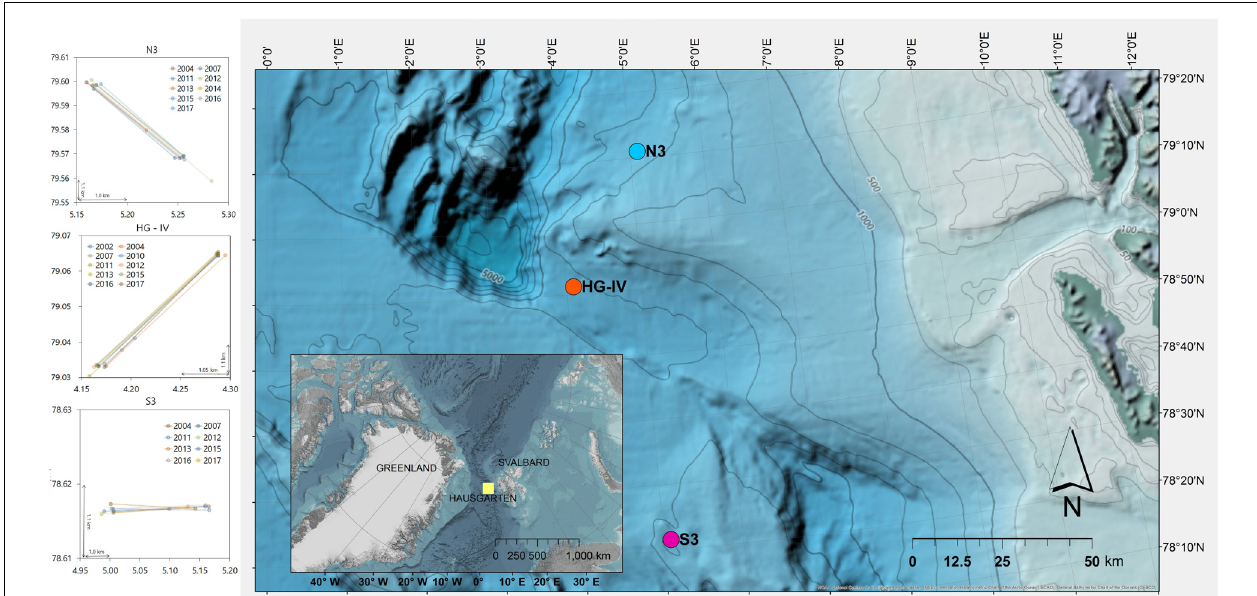
FIGURE 1 | Location of the three stations and the HAUSGARTEN observatory and camera tracks at each site.